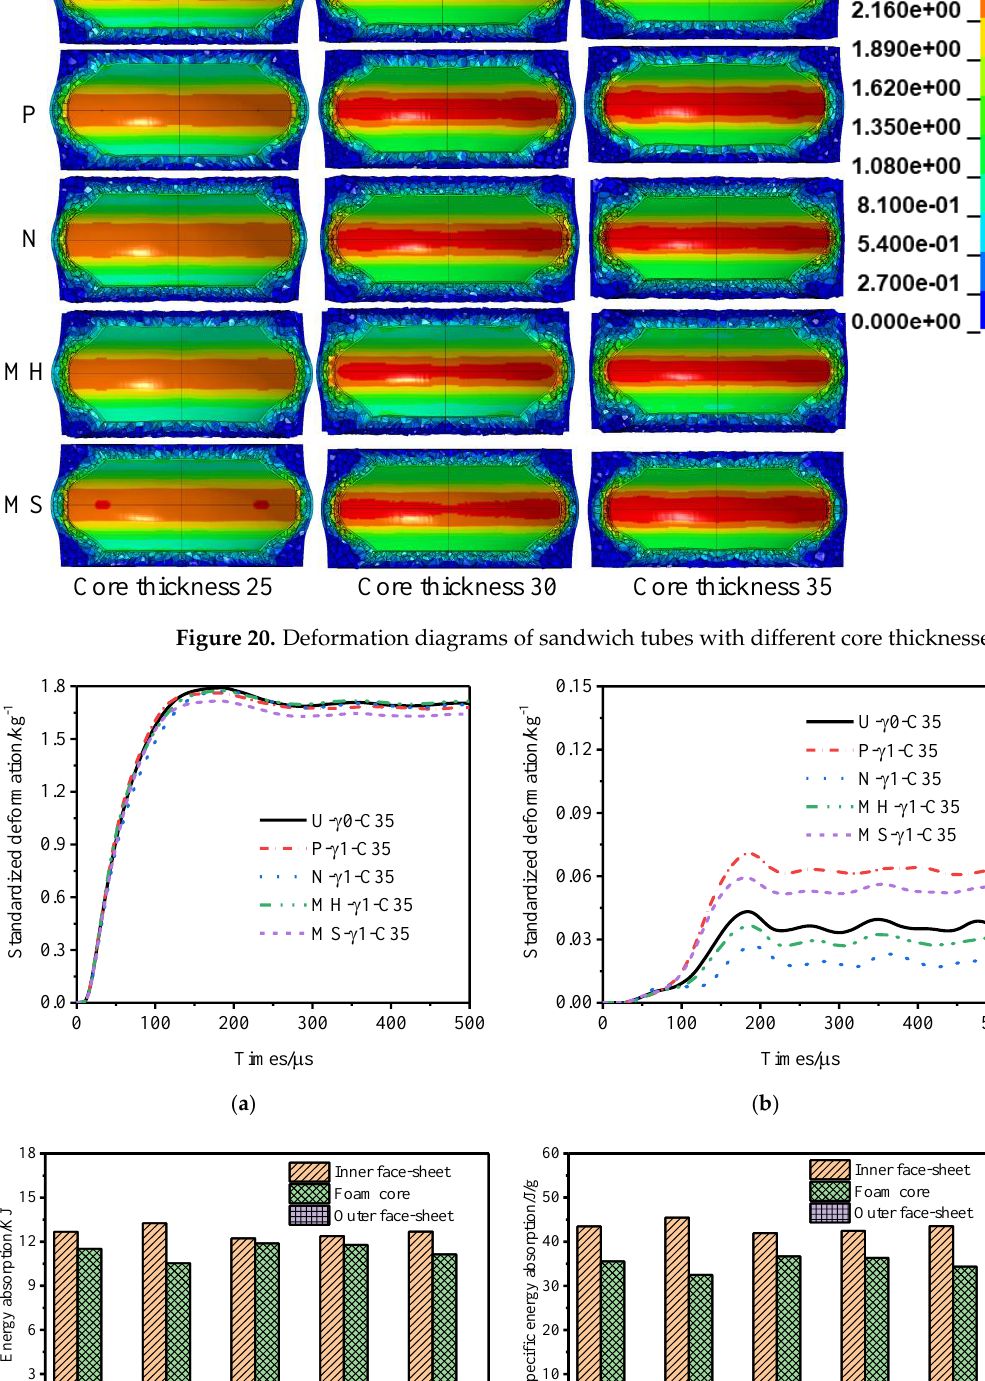
Figure 21. Anti − explosion performance of a foamed aluminum sandwich tube when the core thickness is 35 mm. ( a ) Deformation curve of the inner tube, ( b ) deformation curve of the outer tube, ( c ) total energy absorption of the sandwich tube, and ( d ) specific energy absorption of the sandwich tube.